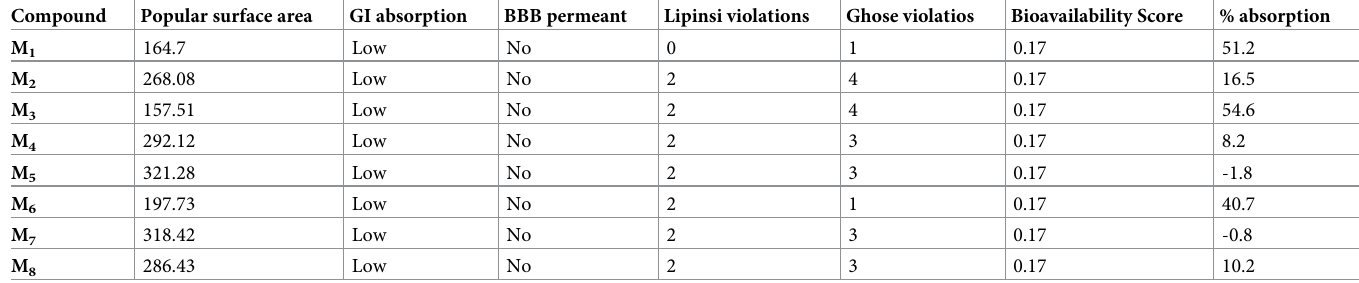
Table 5. Predicted ADME properties of derivatives of 3-((5-(dimethylcarbamoyl)pyrrolidin-3-yl)thio)-6-(1-hydroxyethyl)-4-methyl-7-oxo-1-azabicyclo[3.2.0]hep- tane-2-carboxylic acid. Compound Popular surface